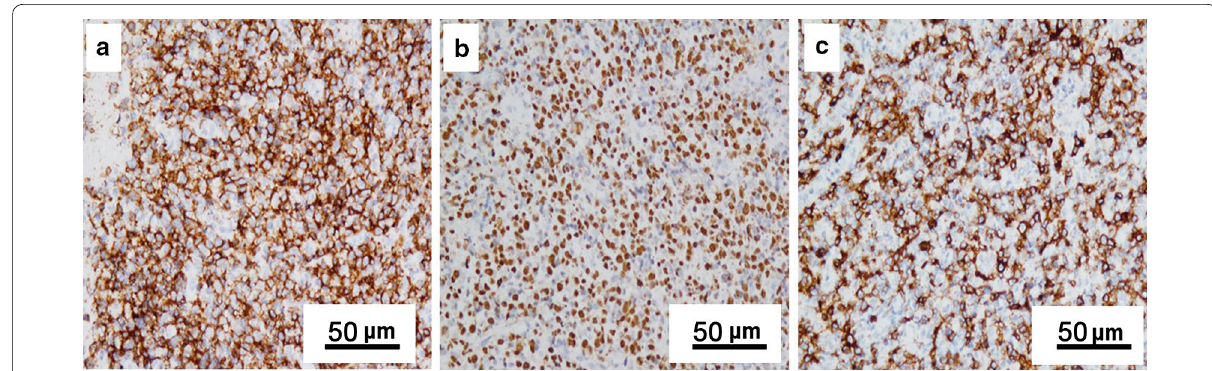
Fig. 2 Immunohistochemical staining (IHC) and in situ hybridization (ISH) staining of ENKTL. a Tumor cells show strong membranous and cyto- plasmic expression of CD56 (IHC, 200). b Tumor cells show strong nuclear expression of Epstein-Barr virus (EBV)-encoded small RNA (ISH, × Tumor cells show strong diffuse membranous and Golgi zone expression of CD30 (IHC,